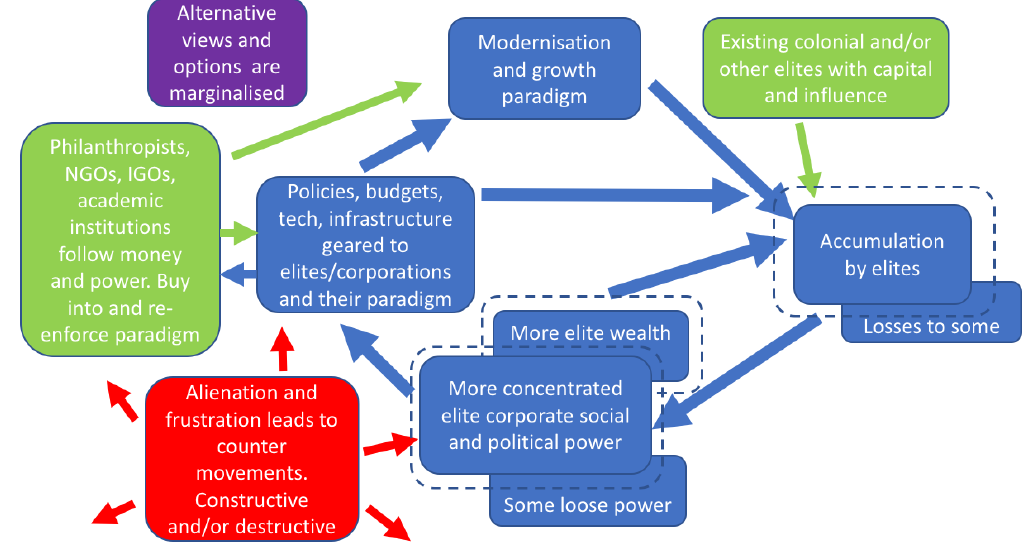
Figure 2. Reinforcing cycles of land and inequality (Source: the authors).